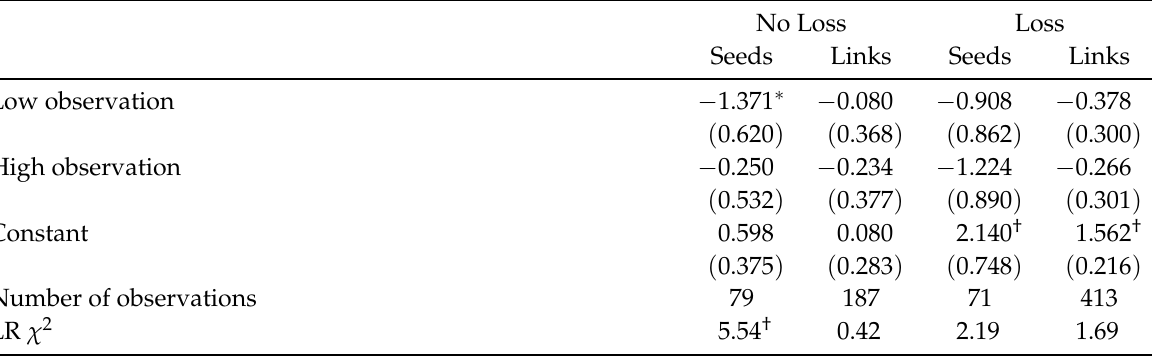
Table 2: The effect of third-party influence on the amount transferred from the next